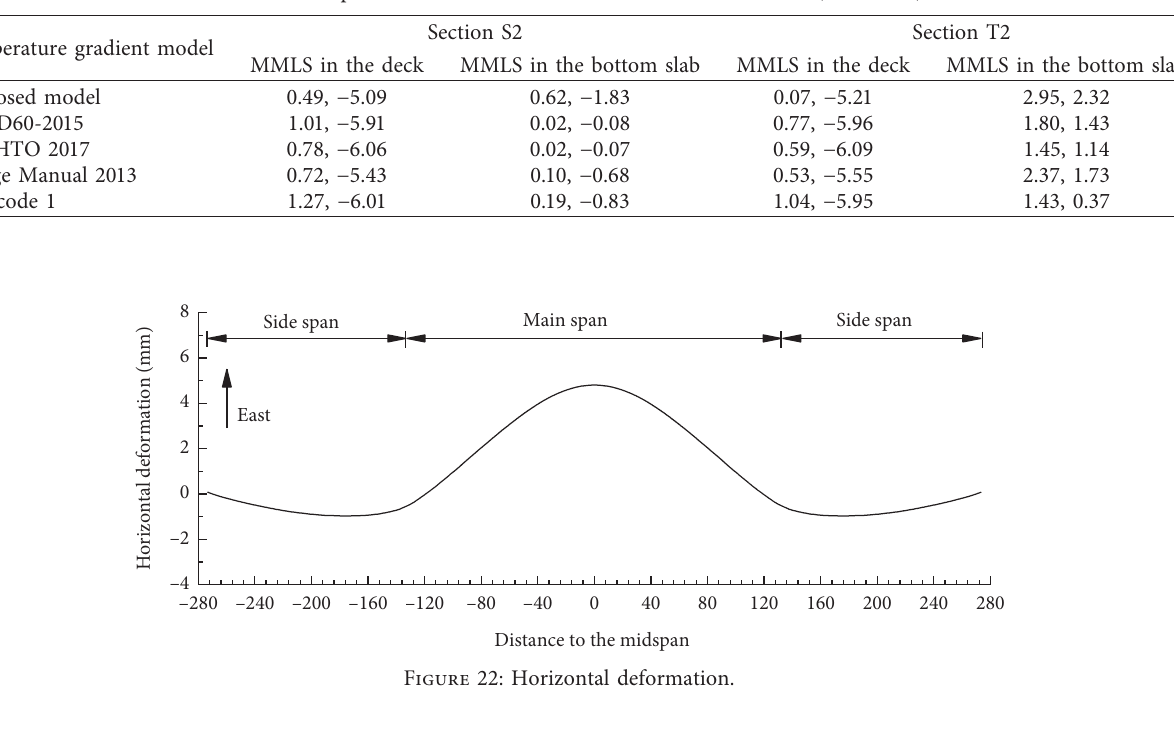
Table 4: Comparison of the MMLS in the deck and bottom slab (unit: MPa).